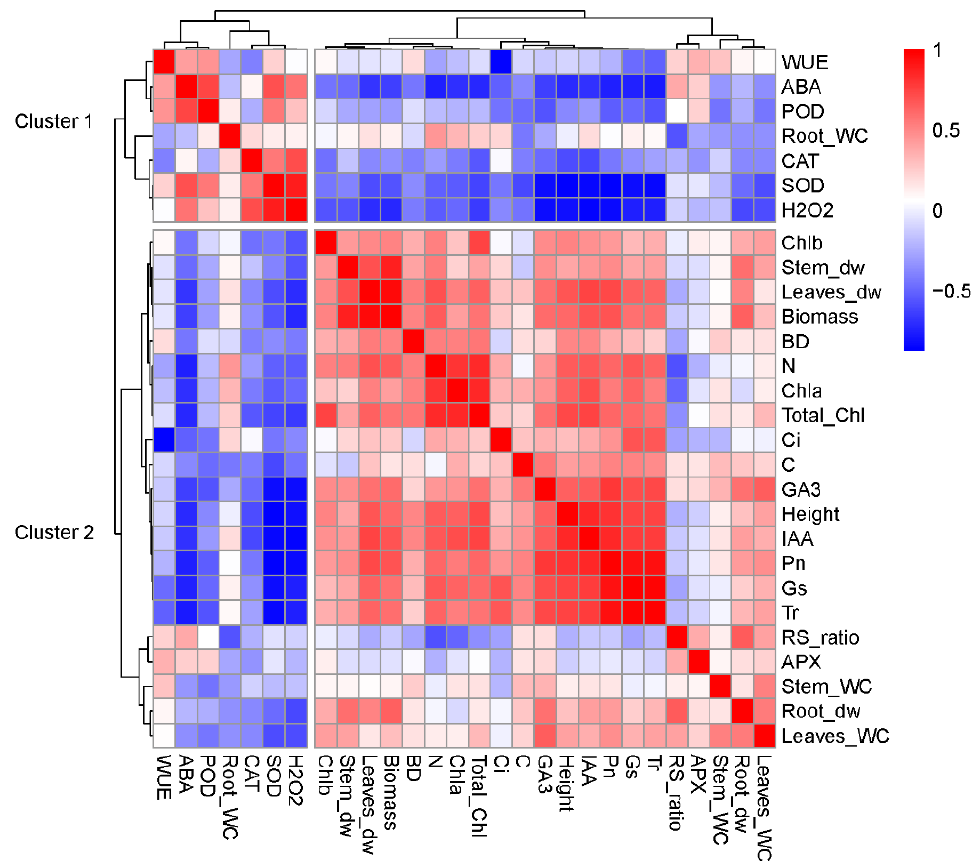
Figure 7. The PCA of all physiological parameters of S. myrtillacea . ( a ) The samples’ score plot of PCA; ( b ) the loading plot of PCA (cos2 denotes quality of parameter, red represents higher quality of parameter on PC1 and PC2); ( c ) the quality of representation of physiological parameters; ( d ) the contributions of physiological parameters to PCs.